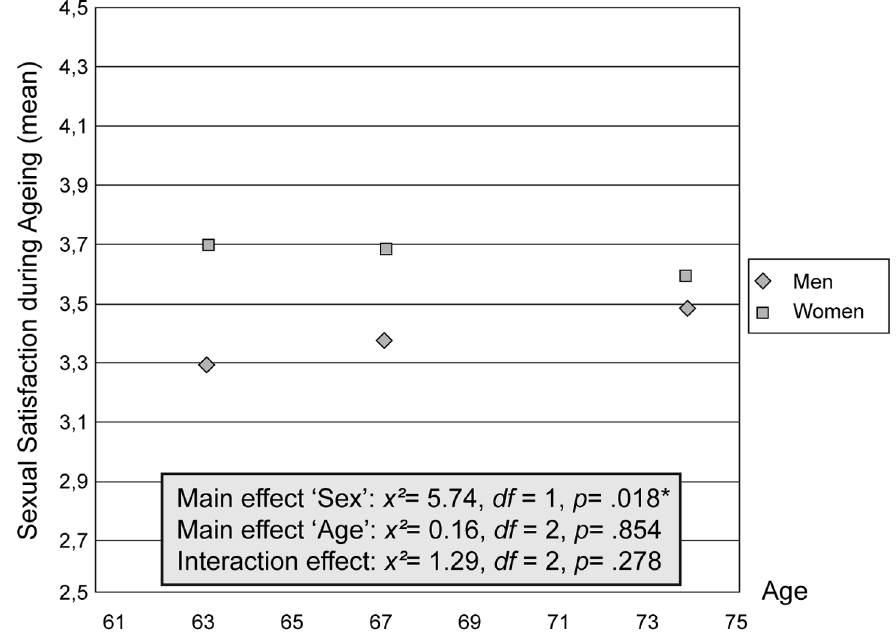
Figure 2. Satisfaction with sexual activity during ageing: mean-values, differentiated by gender. In the box are the results of the nonparametric repeated measures analysis of variance (Kruskal-Wallis-Test; Friedmann-Test). *p , .05.